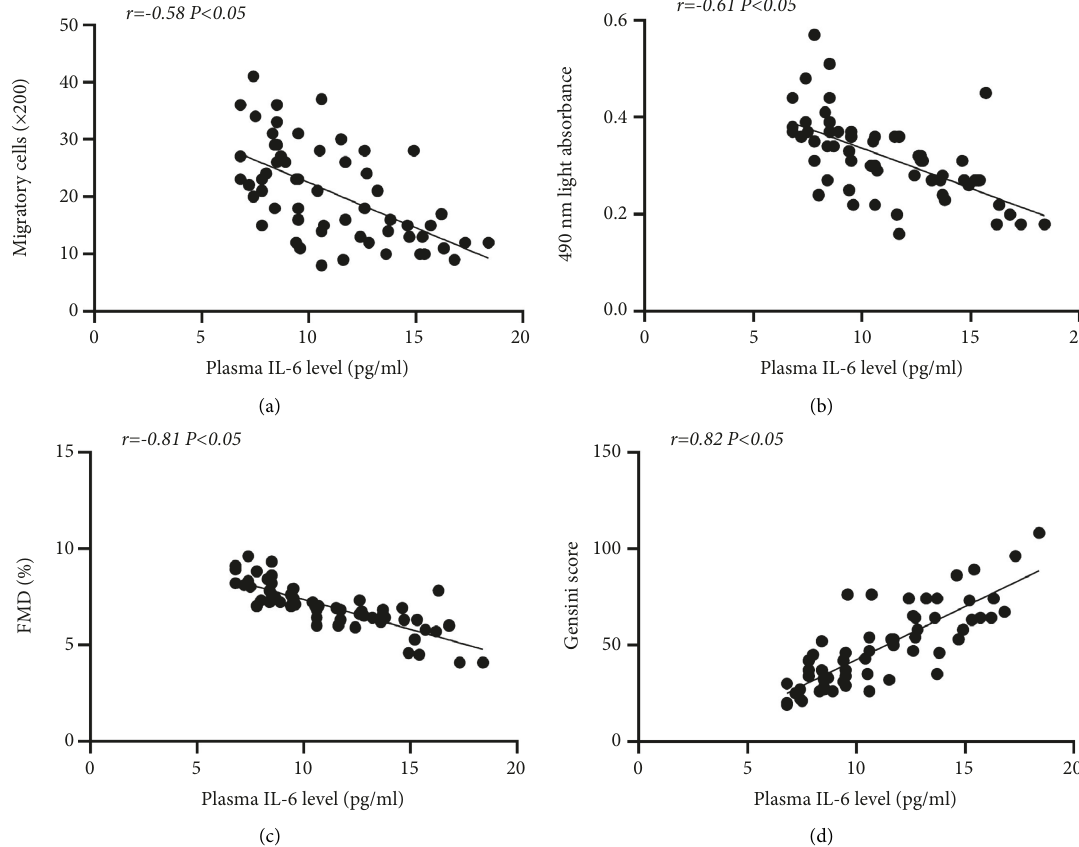
Figure 4: Correlation between the function of circulating EPCs or FMD or the Gensini score and IL-6. EPC migration (a) proliferation (b) and FMD (c) were inversely related to IL-6. In addition, the Gensini score was positively correlated with IL-6 (d) Univariate correlations were calculated using Pearson’s coefficient ( r